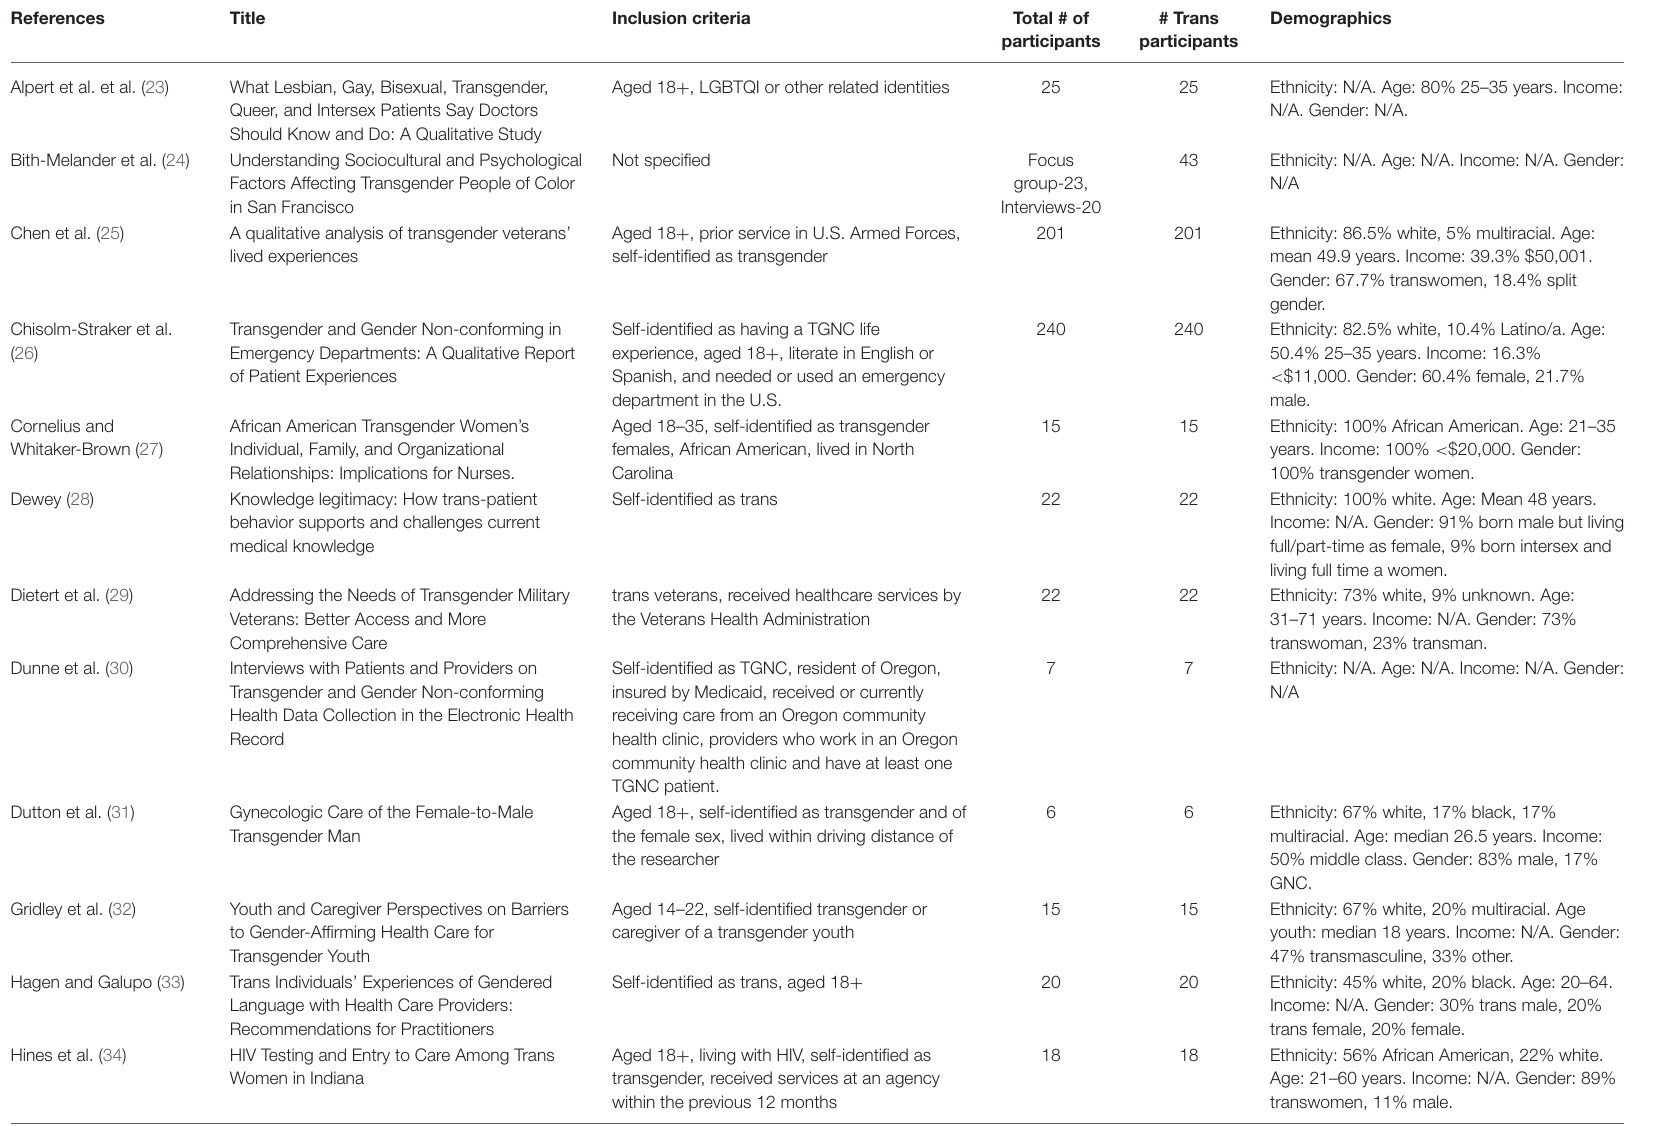
TABLE 2 | Description of study criteria and